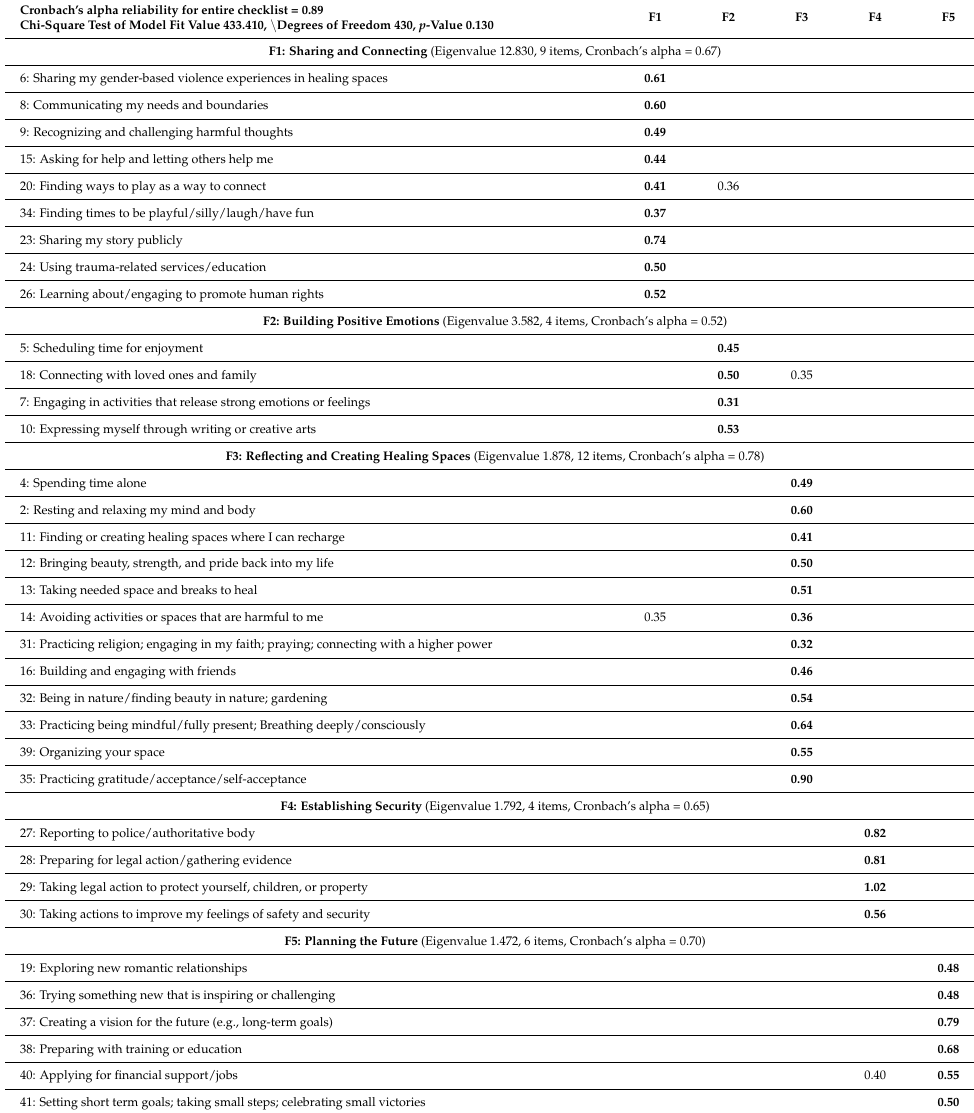
Table 2. Factor Loadings for the Trauma Recovery Action Checklist